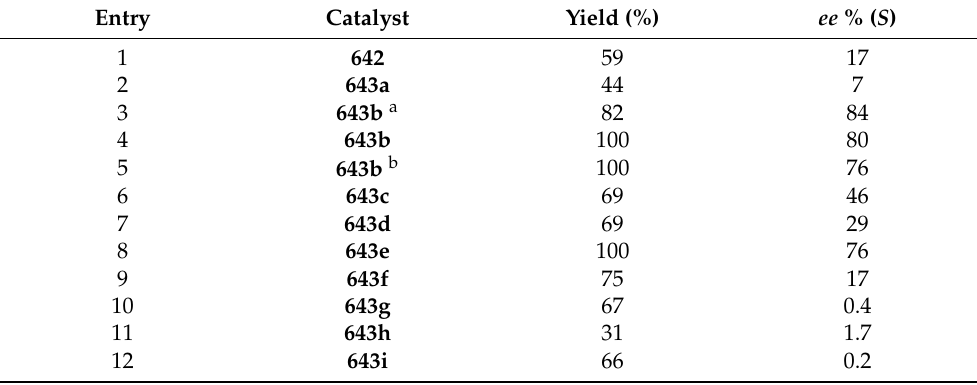
Table 1. The Michael addition of methyl phenylacetate ( 625 , 1.3 equiv.) to methyl acrylate ( 626 ) in the presence of the crown ethers bearing two glucose units (6 mol%) and potassium tert -butoxide (0.34 equiv.). The reactions were conducted at − 78 ◦ C in toluene for 8 min if not specified